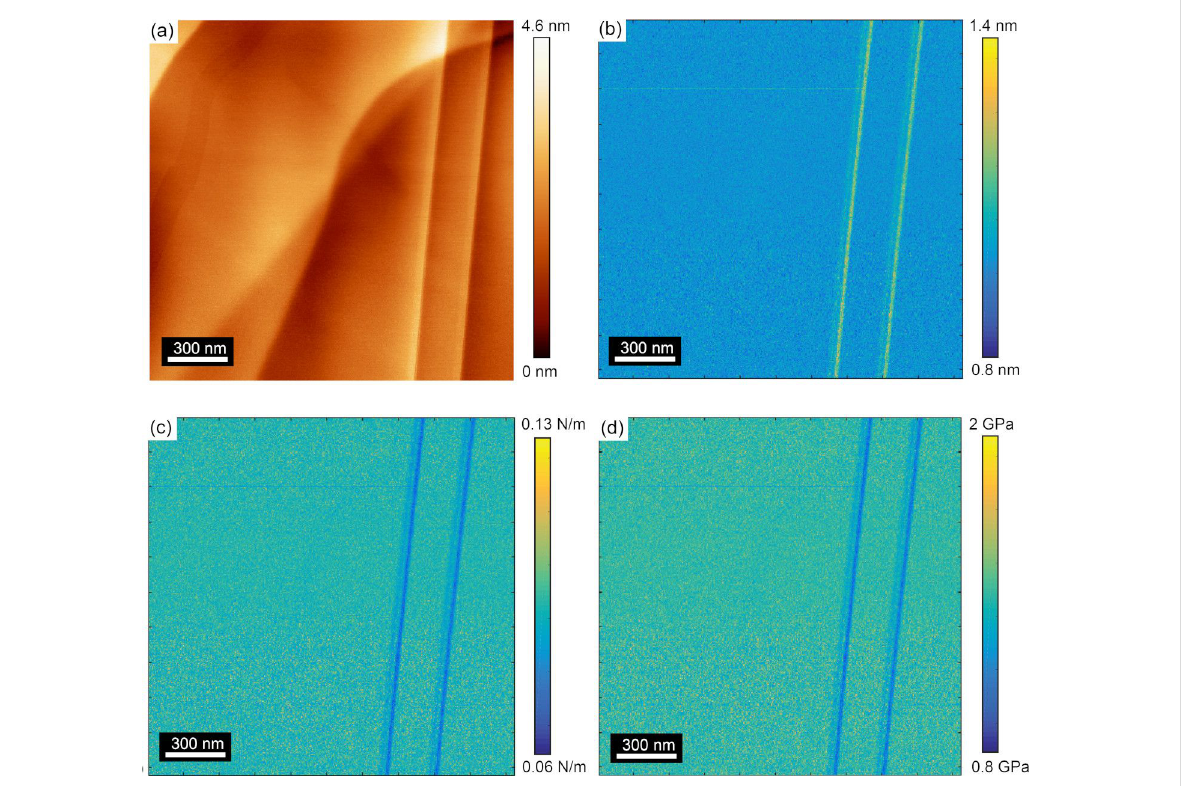
Figure 10: (a) AFM topography image, (b) amplitude, (c) corresponding converted contact stiffness and (d) corresponding converted elastic modulus of the HOPG surface. This series of images was recorded with tip A and with CR ARM (modulation frequency = 77 kHz.)